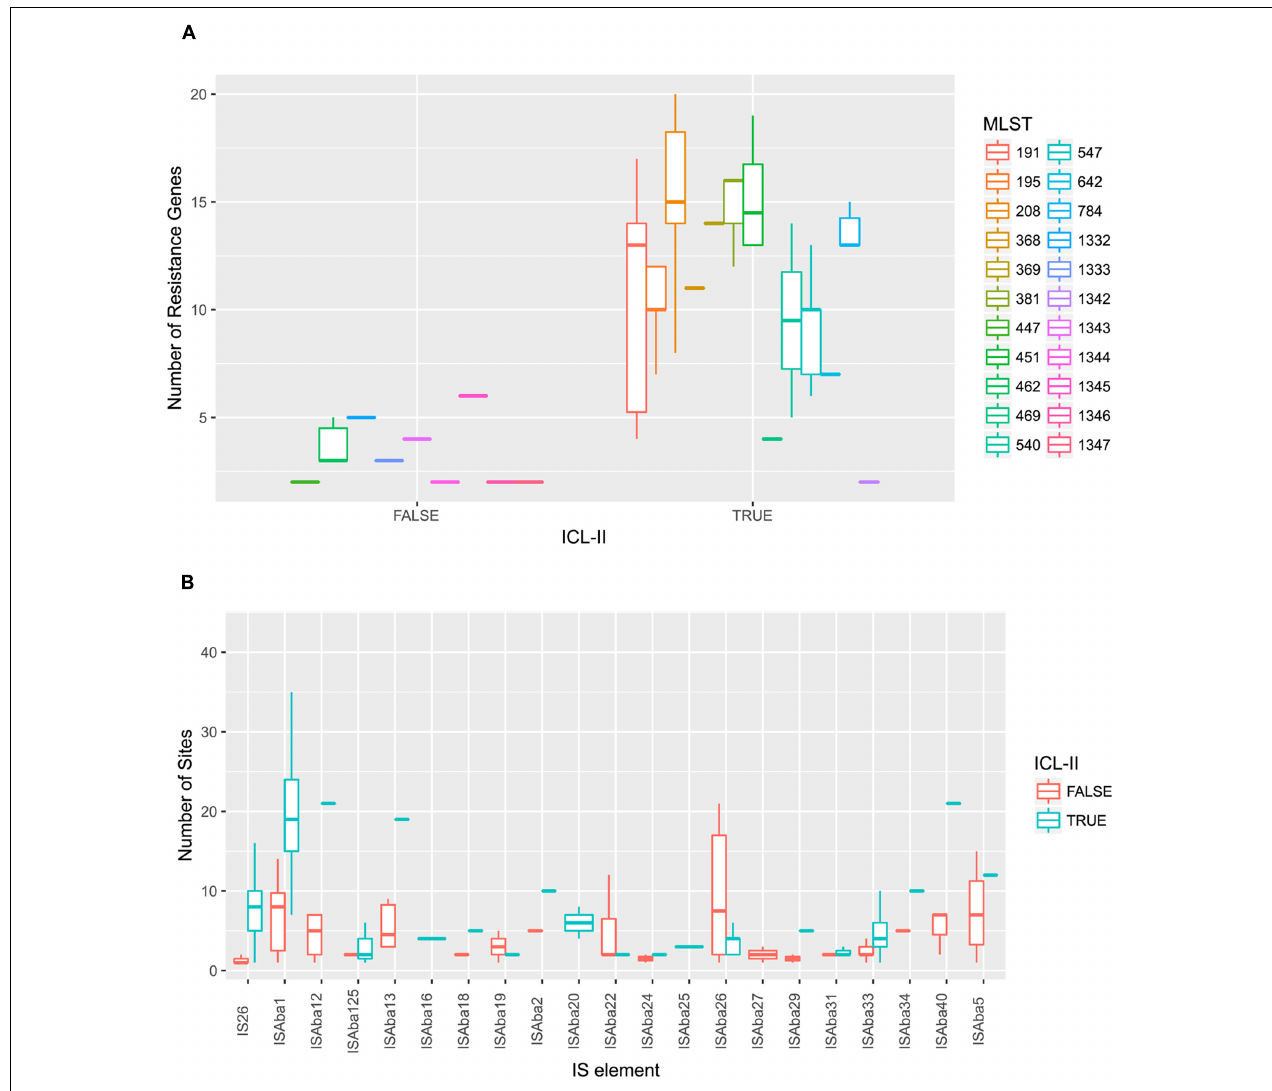
FIGURE 3 | A. baumannii ICL-II presented a higher number of resistance genes and mobile element. (A) A. baumannii ICL-II harbored more resistance gene than non-ICL-II isolates. Colors are indicated for isolates belonging to different MLST. Boxplots for each MLST display the mean number of resistance genes. Dots indicate the number of resistance gene for isolate. (B) A. baumannii ICL-II harbored more IS Aba1 than non-ICL-II isolates. Colors are indicated for isolates belonging to different MLST. Boxplots for each MLST display the mean number of mobile element. Dots indicate the number of ISAba1 for each